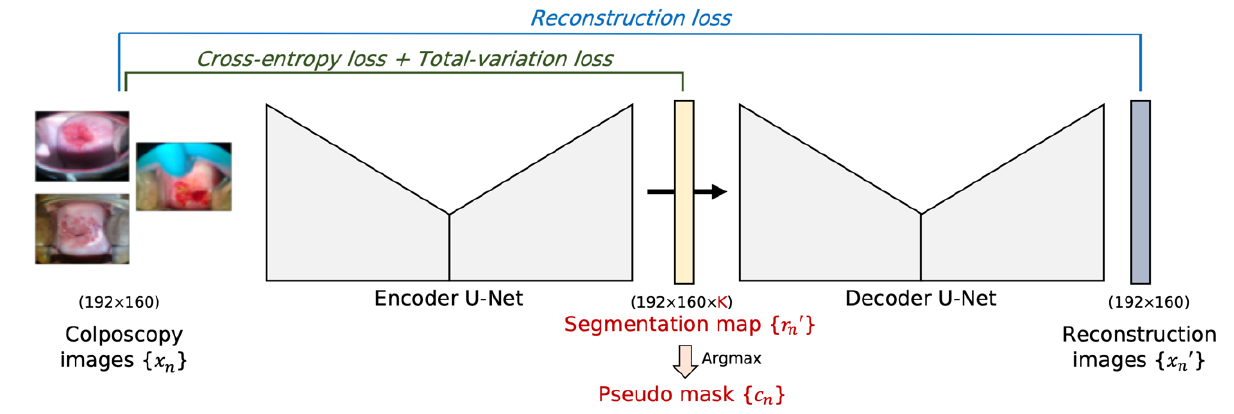
Figure 1. Overview of the proposed W-Net with CT-loss.